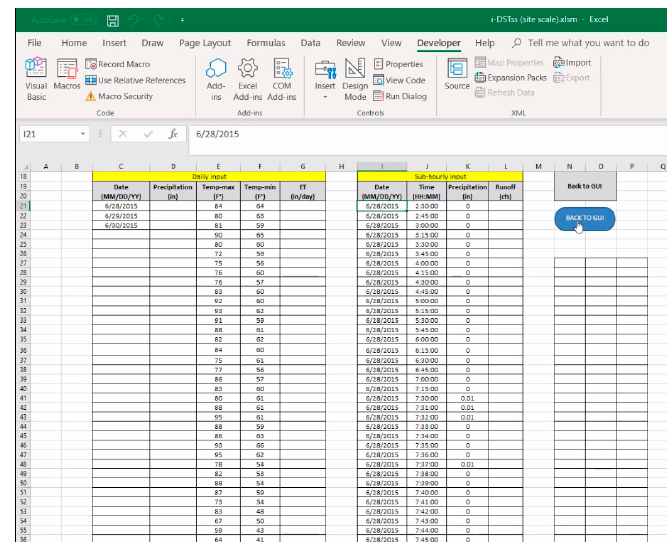
Figure A6. Precipitation time series input page.